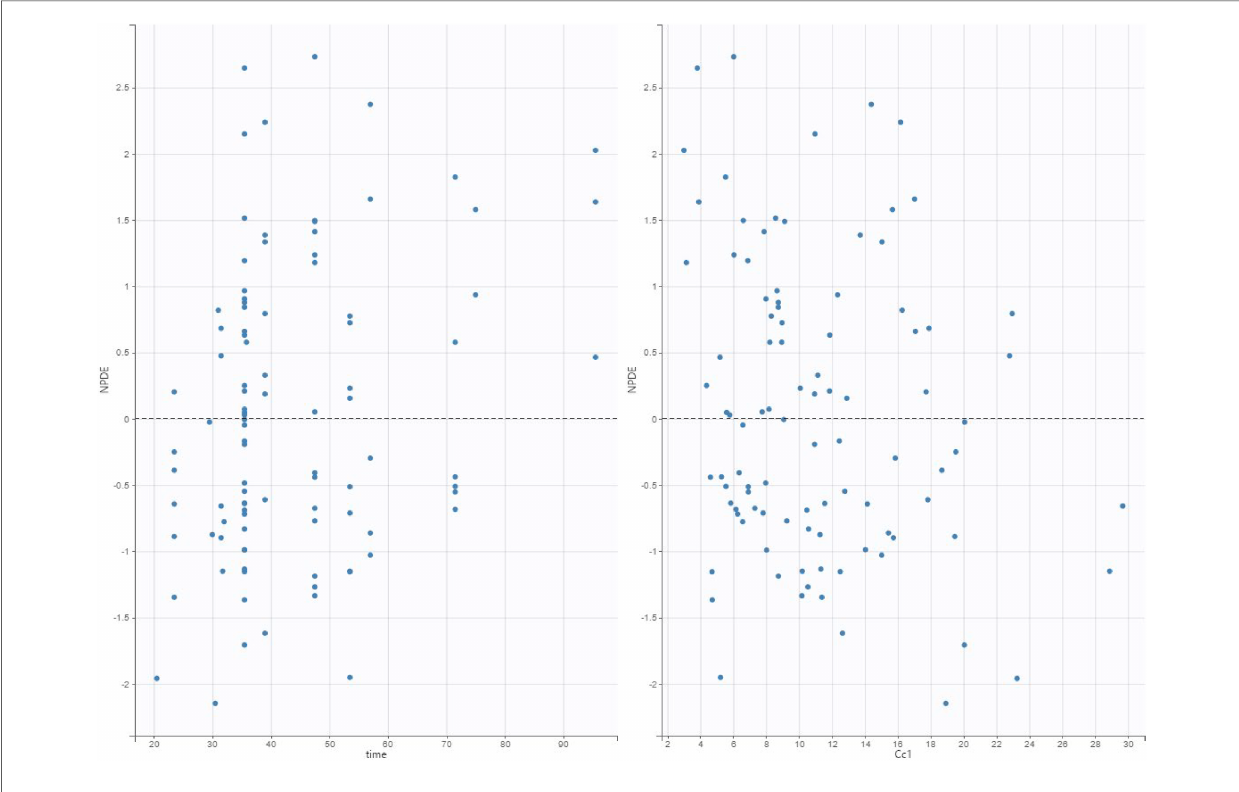
FIGURE 6 Normalized prediction distribution error (NPDE) plot of our fi nal model applied to the validation data set.